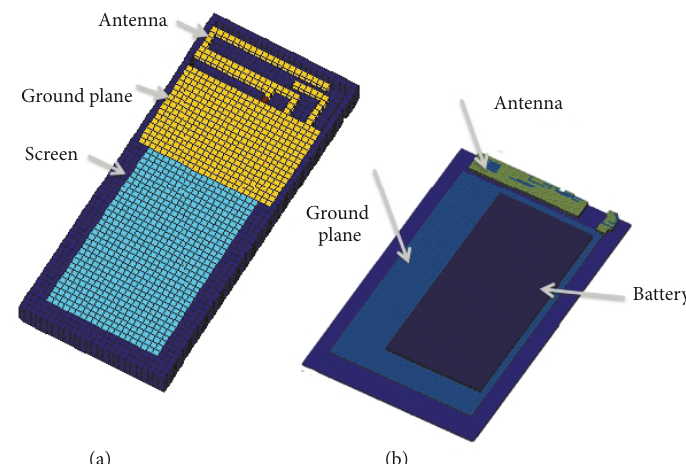
Figure 1: Wireless devices developed using MATLAB: (a) a mobile phone and (b) a tablet.